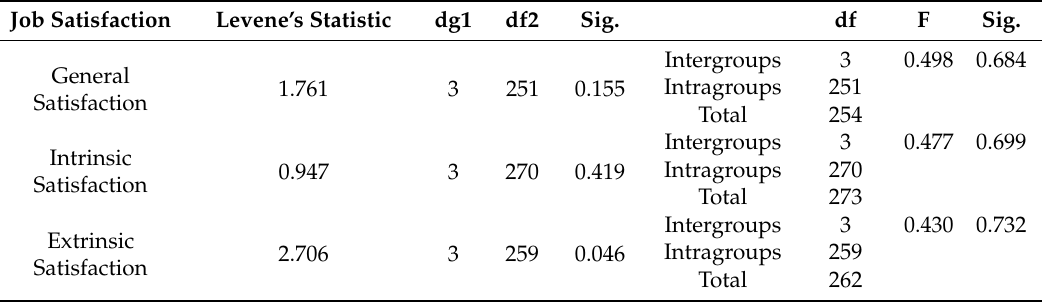
Table 5. Relationship between the general satisfaction dimensions and working